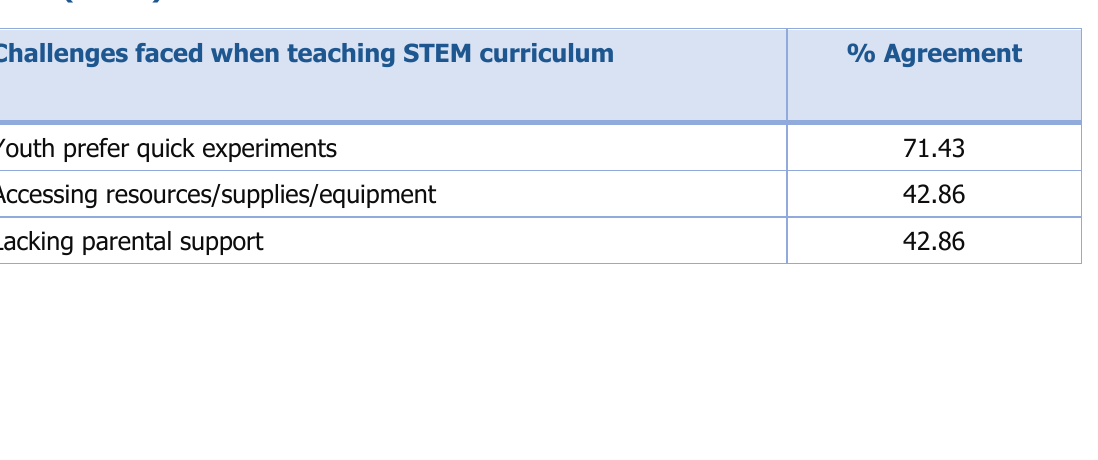
Table 3. Challenges Statements and Agreement Percentages in Round 3: Volunteer Panel (N =